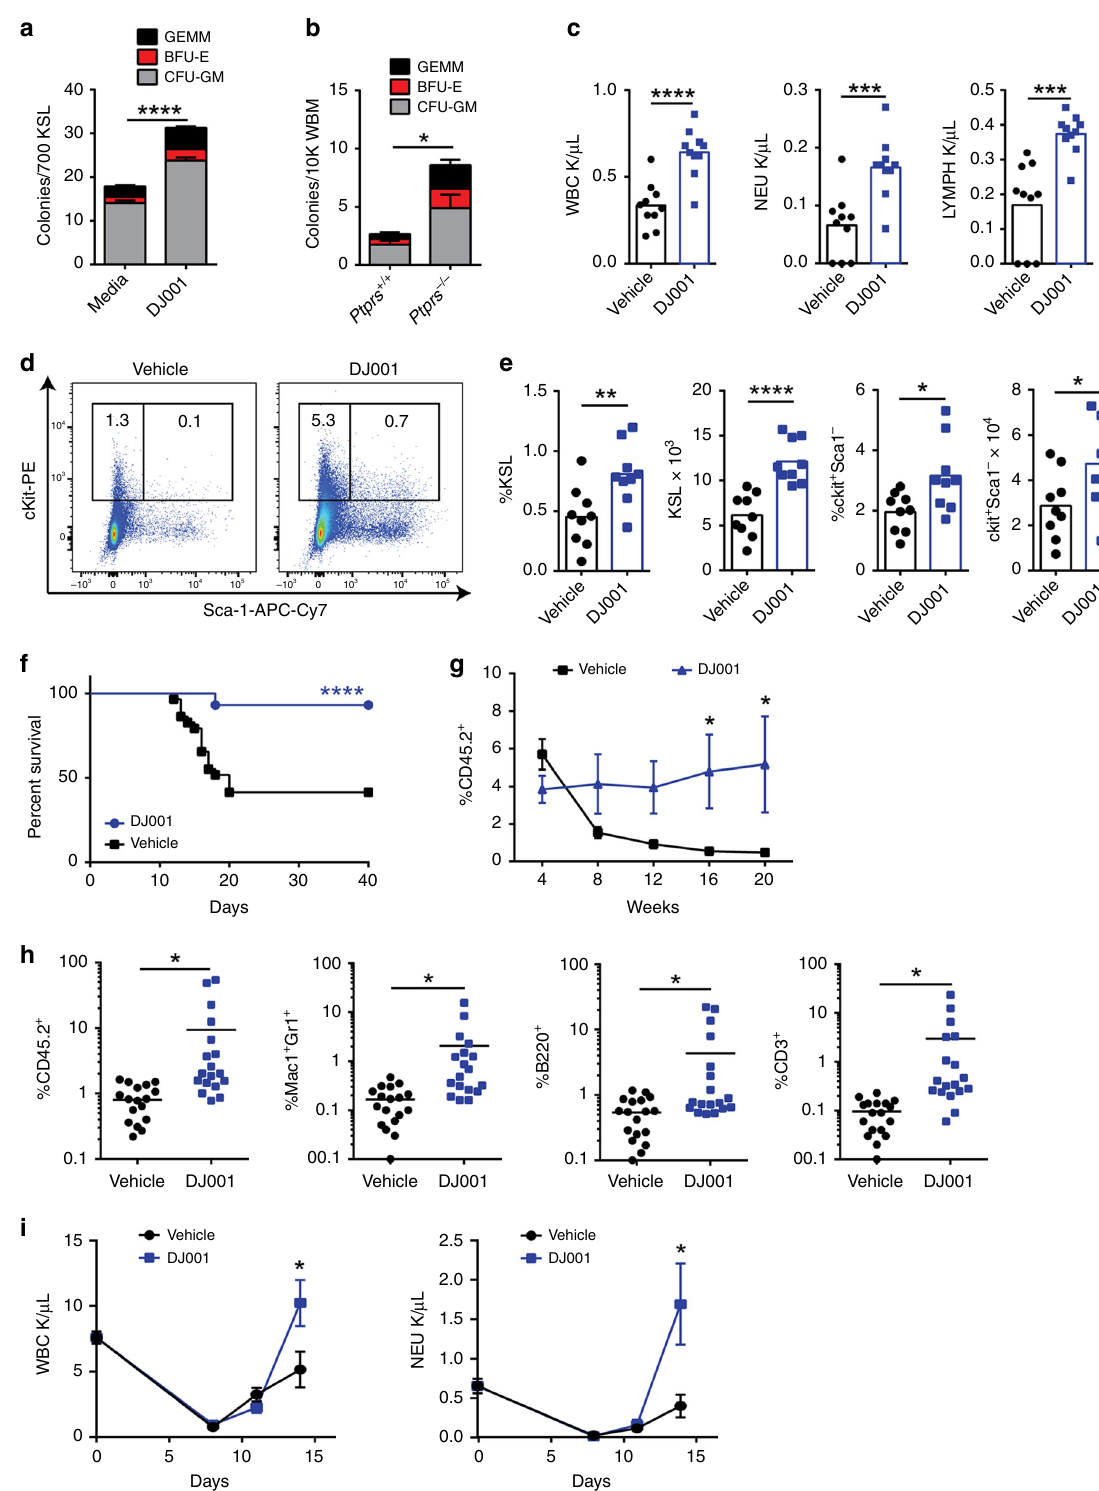
megakaryocyte erythroid progenitors (MEPs), common myeloid progenitors (CMPs), granulocyte monocyte progenitors (GMPs), or PB myeloid, B-cell or T-cell populations, but did cause a modest increase in percentages of BM common lymphoid progenitors (CLPs)(Supplementary Fig. 4d, e). Of note, pharma- cokinetic (PK) analysis of adult C57BL/6 mice treated sub- cutaneously × 1 with 5 mg/kg DJ001 demonstrated DJ001 concentrations of 10 – 100 ng/mL in the PB over several hours